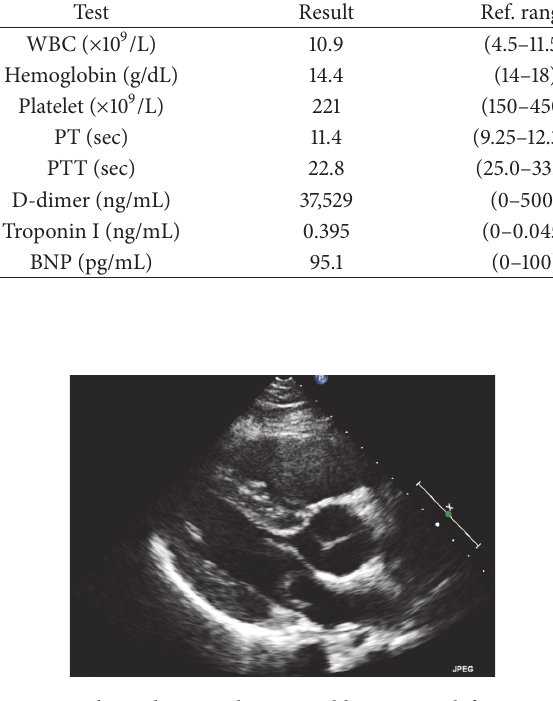
Figure 3: Echocardiogram showing mild concentric left ventricular hypertrophyandaserpentinemassintheleftatrium,consistentwith thrombus.